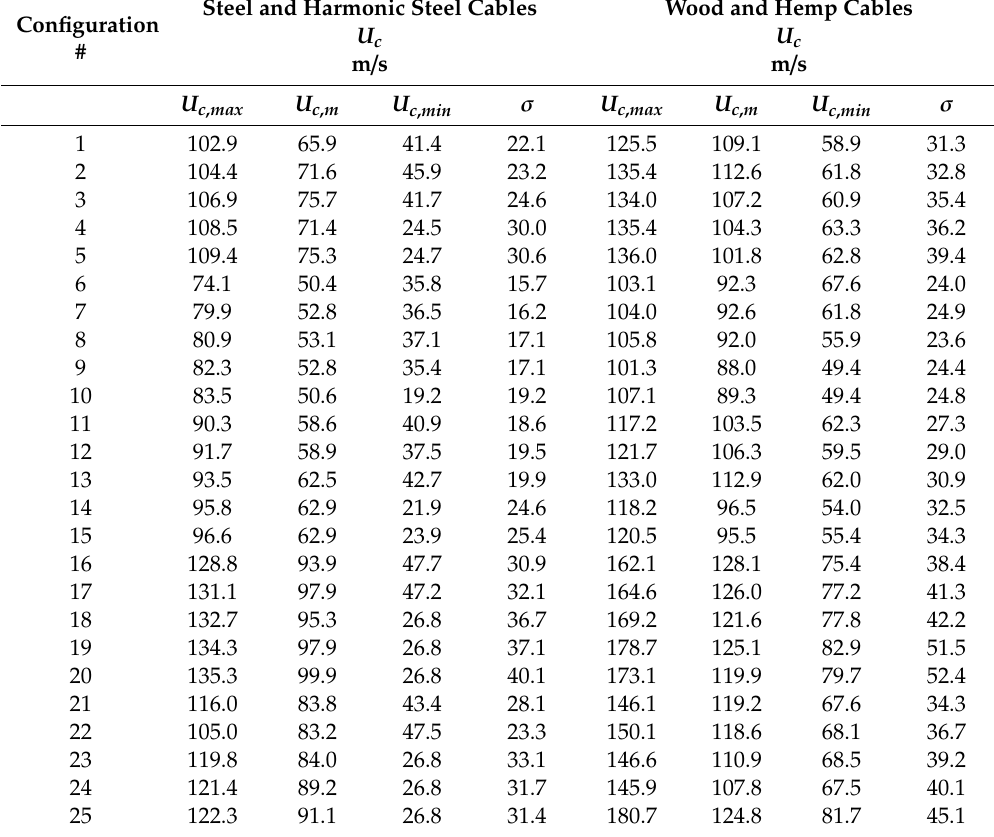
Table 6. Critical flutter speed U c estimated with ζ =